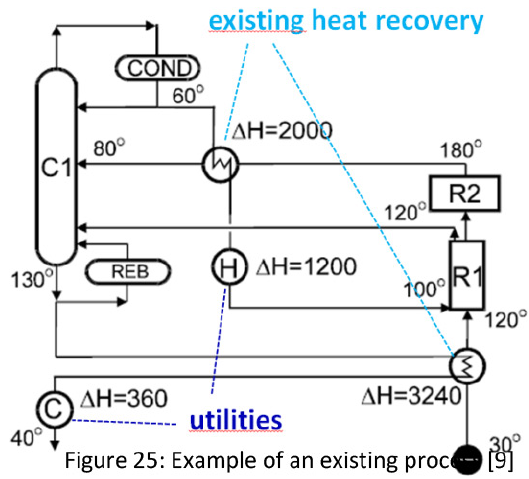
Fig. 25. – Example of an existing process [10].